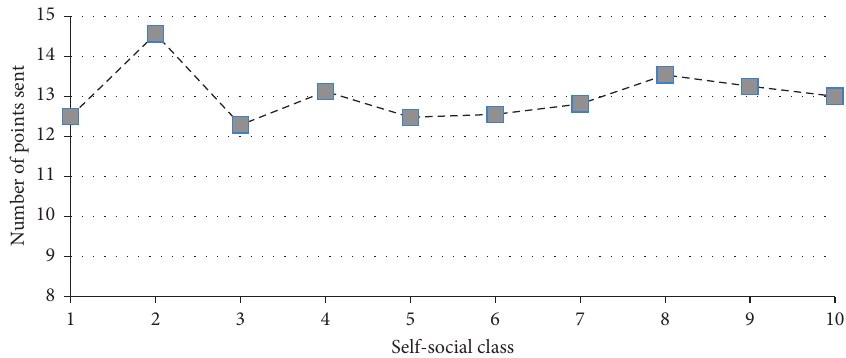
Figure 3: The effect of self-social class on the number of points in a trust game from China university